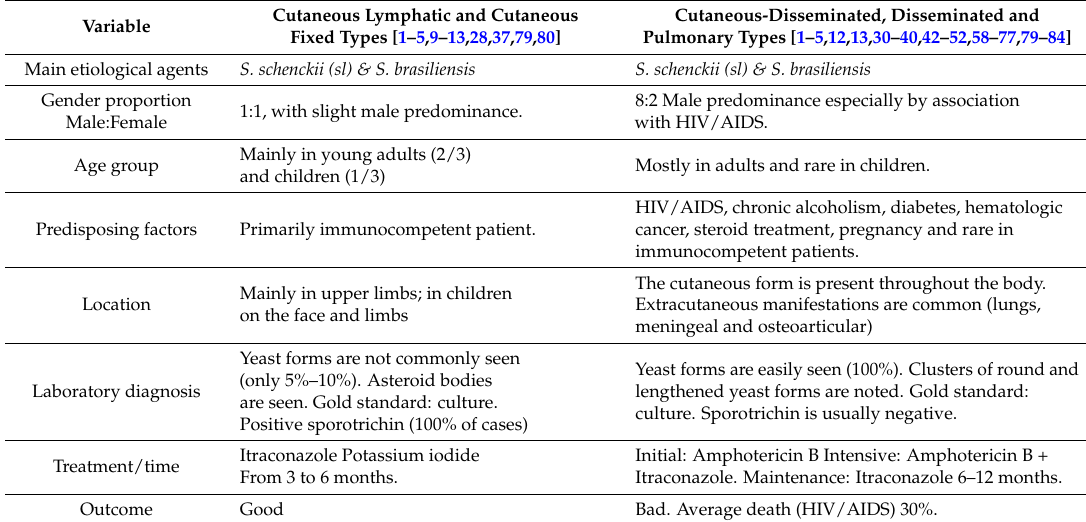
Table 1. Main differences between the types of